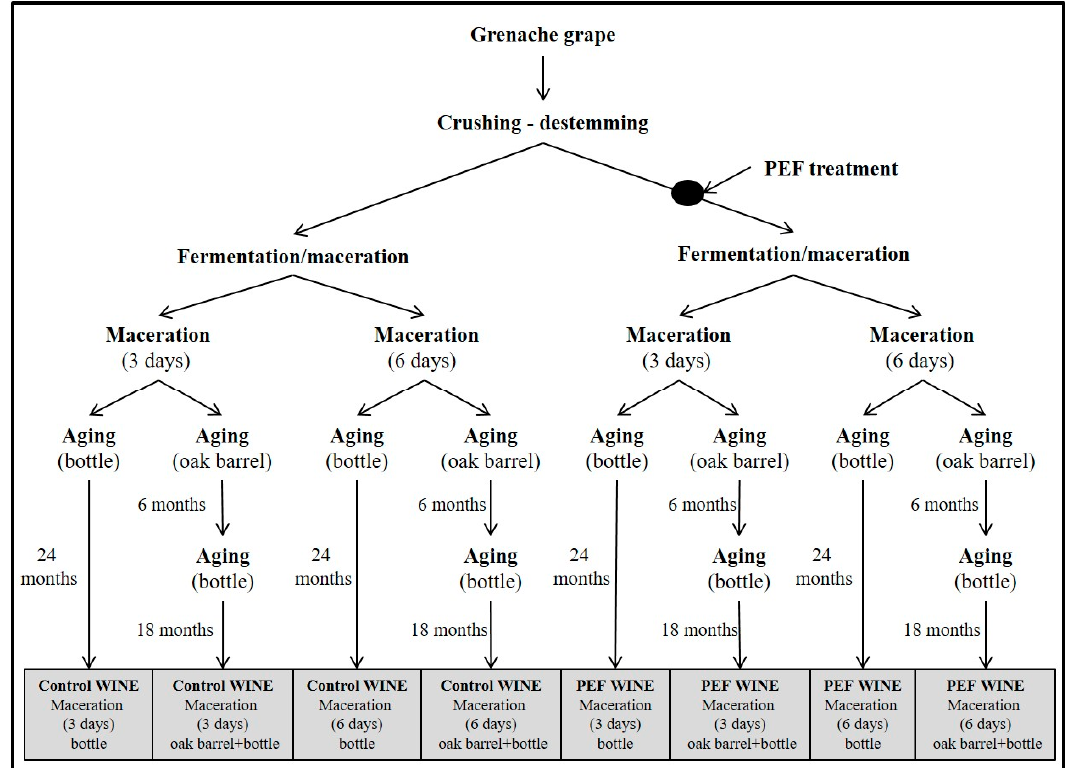
Figure 1. Schematic diagram of vinification and aging.